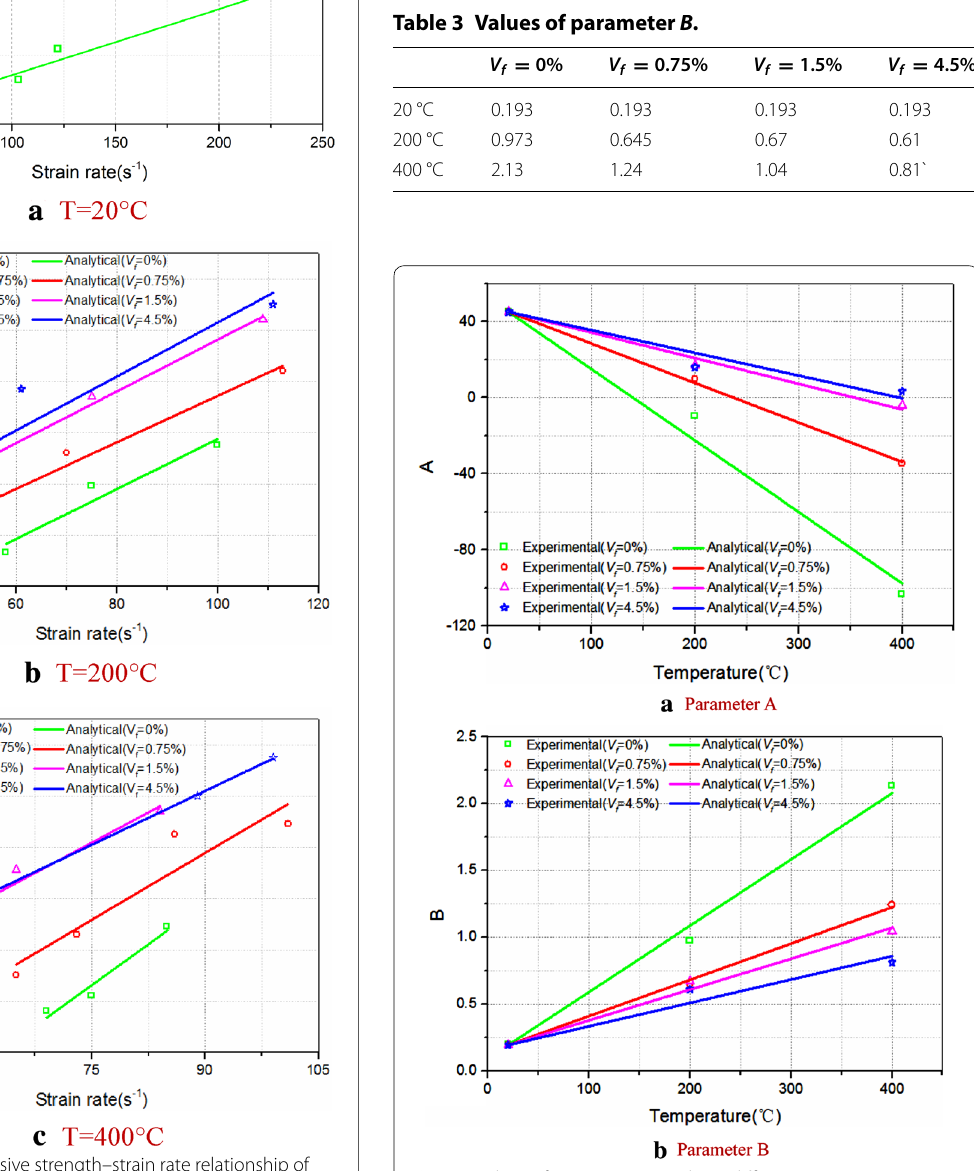
Fig. 18 Values of parameters A and B at different